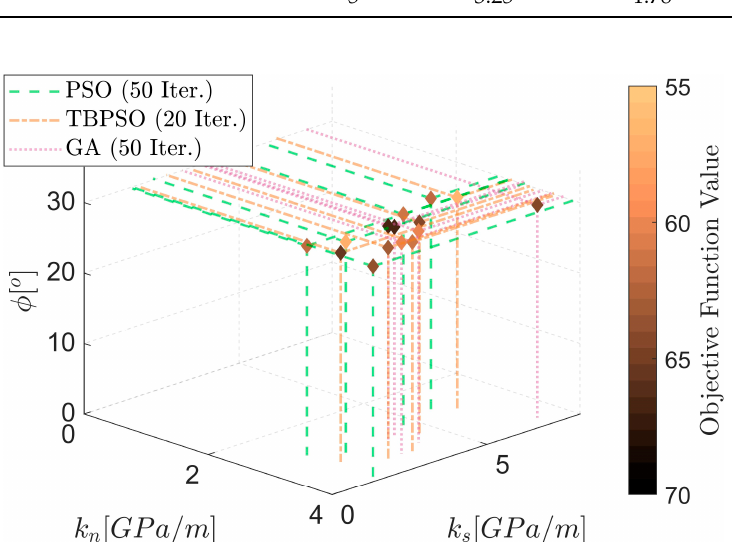
Figure 20. Position of calibrated material parameters of densely meshed geometry (objective function 1, PSO and GA: 50 iterations; TBPSO: 20 iterations).